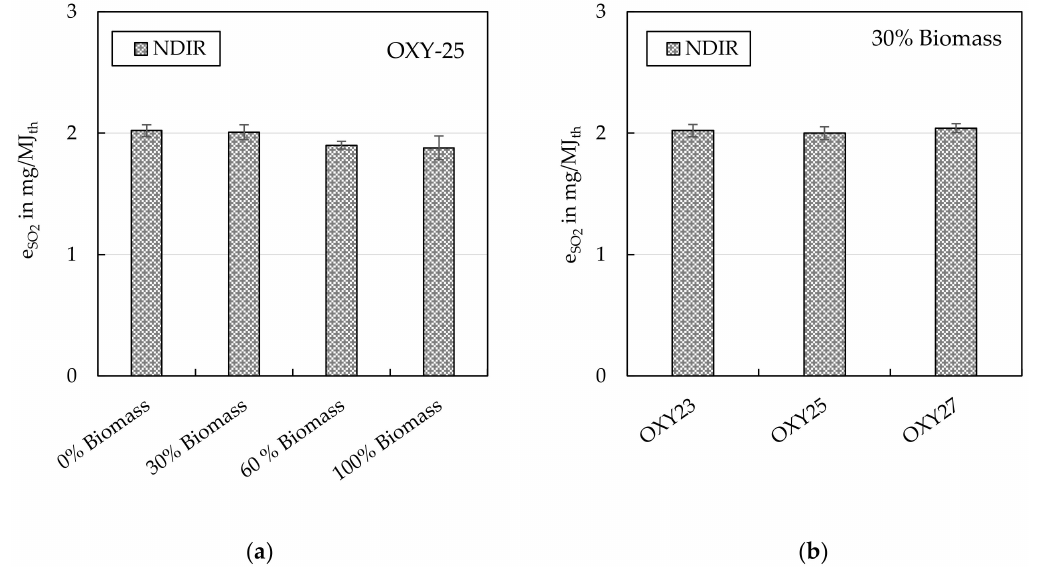
Figure 4. Specific SO 2 emissions ( e SO